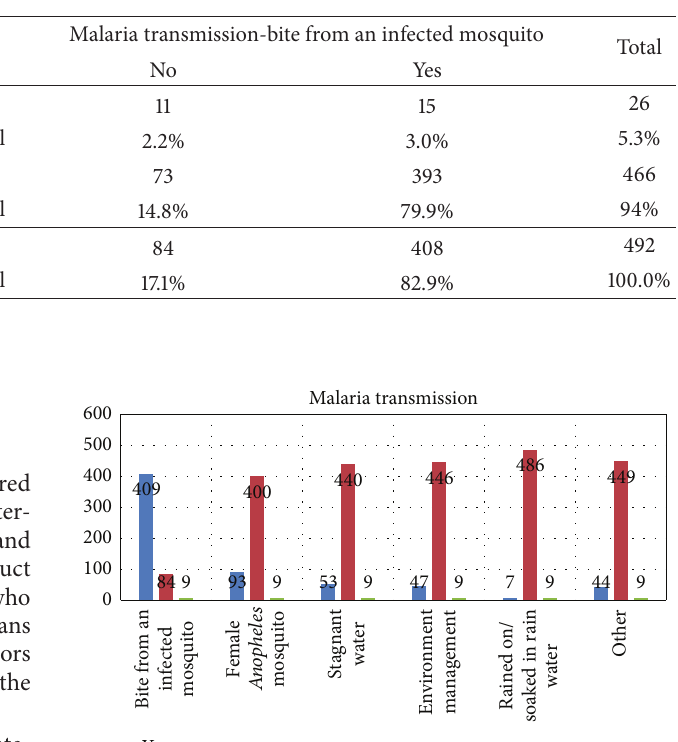
Table 4: Major diseases in the community-malaria (malaria transmission-bite from an infected mosquito cross tabulation).